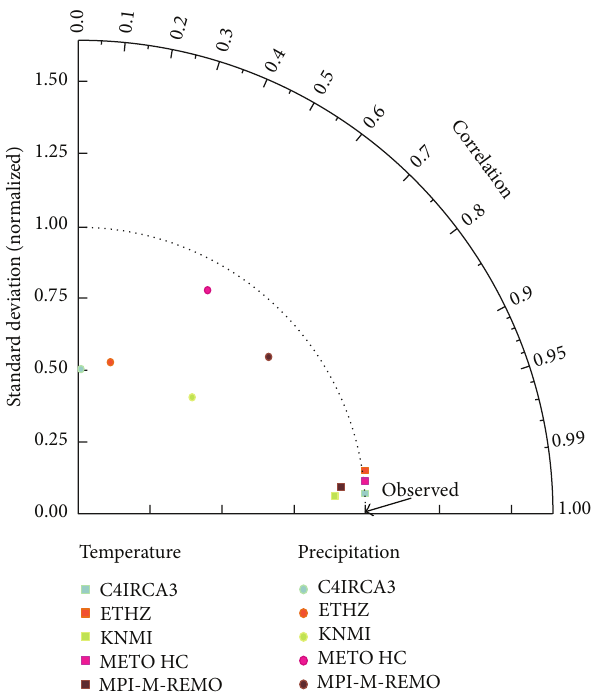
Figure 2: Taylor diagram—the standard deviation and correlation of the validated models with observations for temperature and precipitation (mean value for all the stations around Poland).